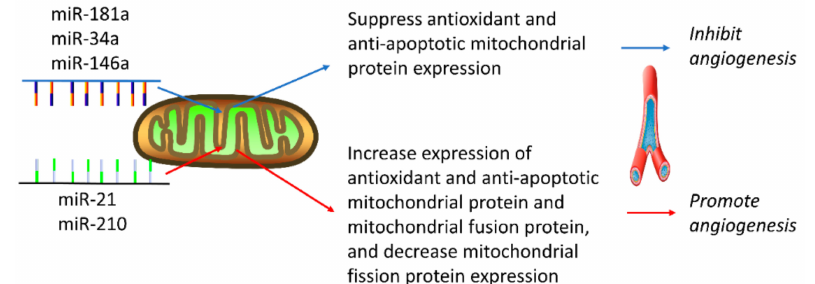
Figure 2. MitomiRs activity in vascular diseases: anti- or pro-angiogenic role. Some mitomiRs, such as miR-181a, miR-34a, and miR-146a, inhibit angiogenesis through suppressing antioxidant and anti-apoptotic mitochondrial protein to increase ROS production and cell apoptosis. Meanwhile, others, such as miR-21 and miR-210, play a pro-angiogenic role through enhancing mitochondria-mediated apoptosis